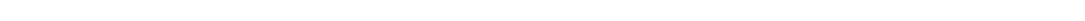
Fig. 2 Liver-speci fi c Phf2 overexpression causes quick-onset hepatosteatosis. a – h Mice, injected with either GFP or Phf2 overexpressing adenovirus,